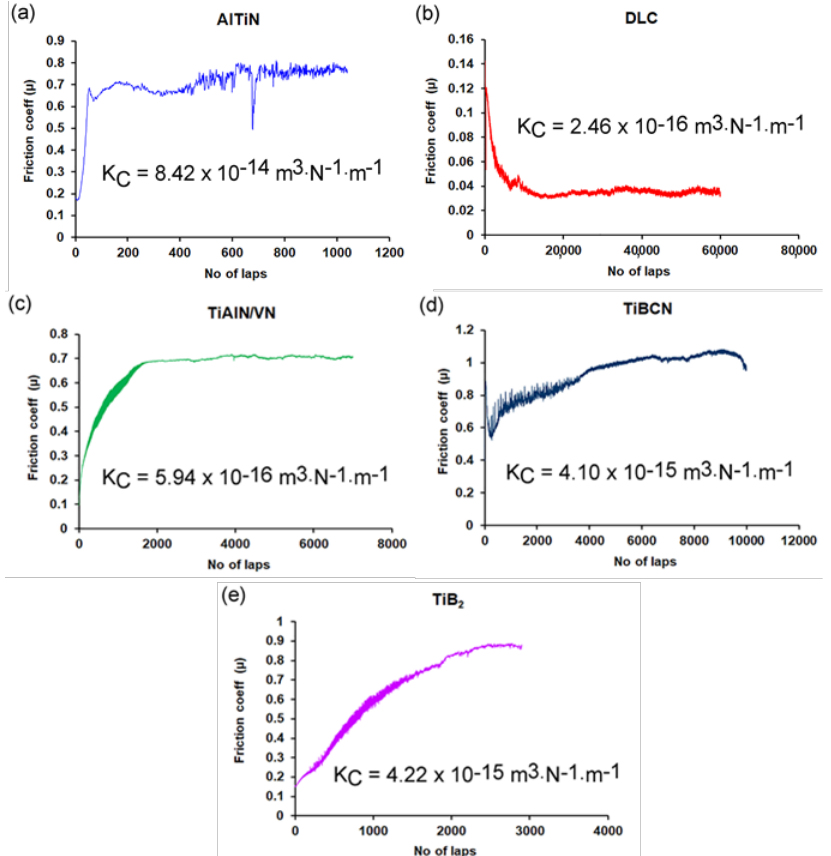
Figure 6. Friction coefficients recorded under 5 N normal load when sliding against Al 2 O 3 ball at room temperature: ( a ) AlTiN ( b ) DLC ( c ) TiAlN/VN ( d ) TiBCN ( e ) TiB 2 . In contrast, the friction curve for nanoscale multilayer TiAlN/VN coating had a smooth appearance in the steady state conditions and attained a mean value of µ = 0.70. SEM images (not included) showed shallow grooving and evidence of oxide formation in ers were removed due to the sliding action of the counterpart, dome shaped columnar